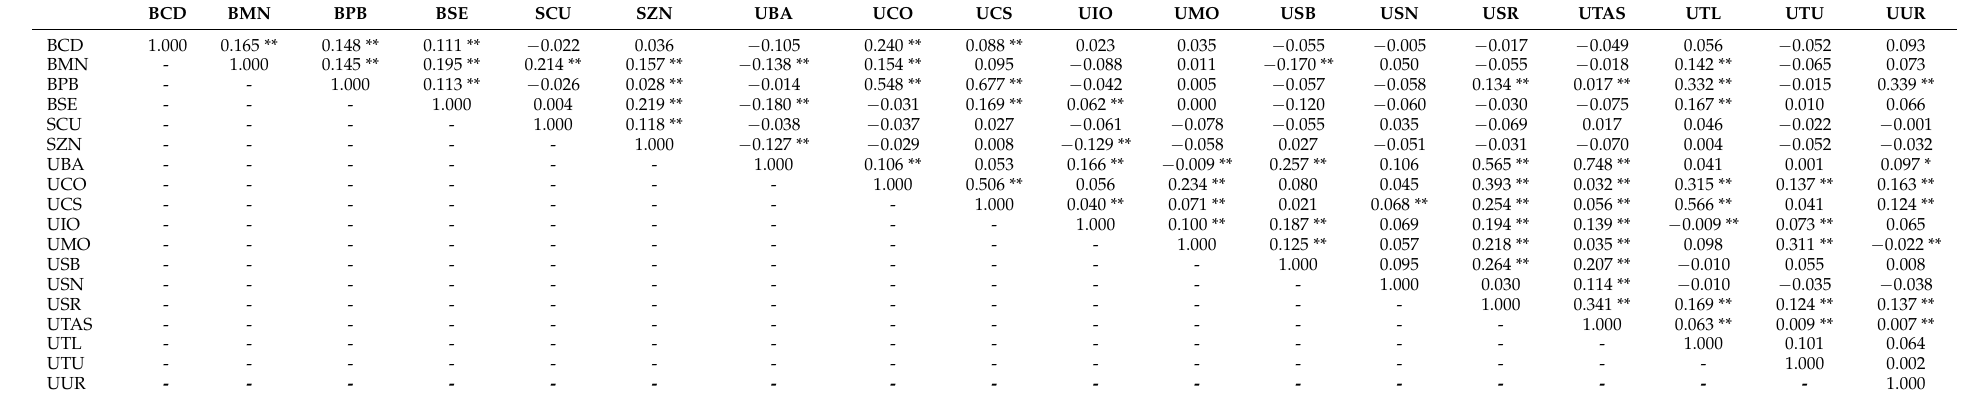
Table 4. Correlations and Hoeffding’s Independence Test Table among